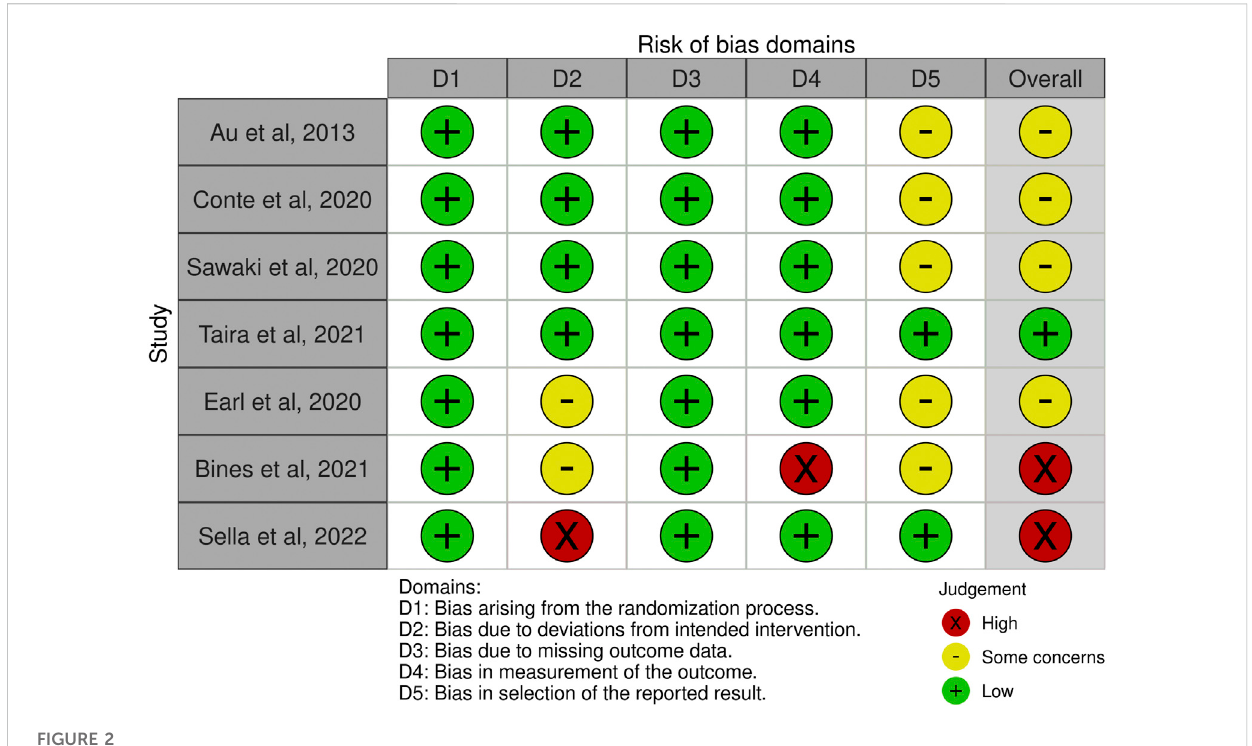
FIGURE 2 Result of risk of bias using RoB 2.0